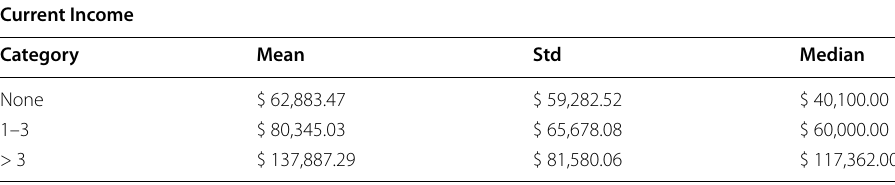
Table 4 First Income and Current Income median, mean, and standard deviation statistics by Years Worked Foreign variable